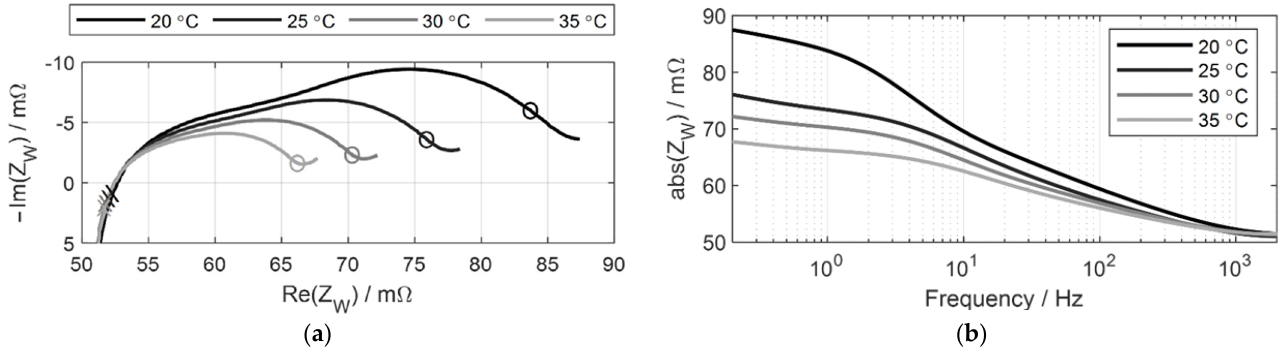
Figure 6. The temperature change of the battery cell during discharging at 1C current.